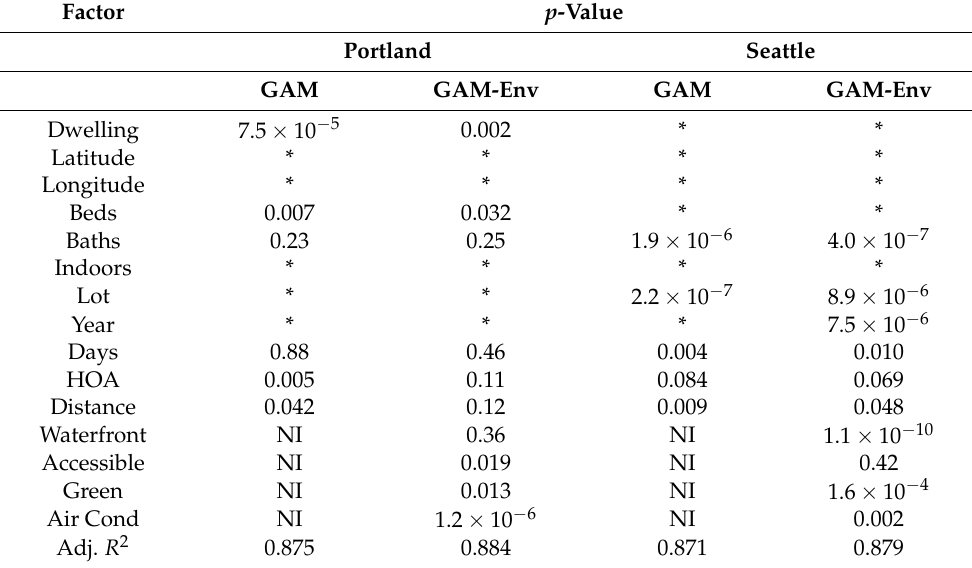
Table 4. Significance ( p -value) of GAM pricing model factors with and without the inclusion of environmental factors. Factor p -Value Portland Seattle GAM GAM-Env GAM